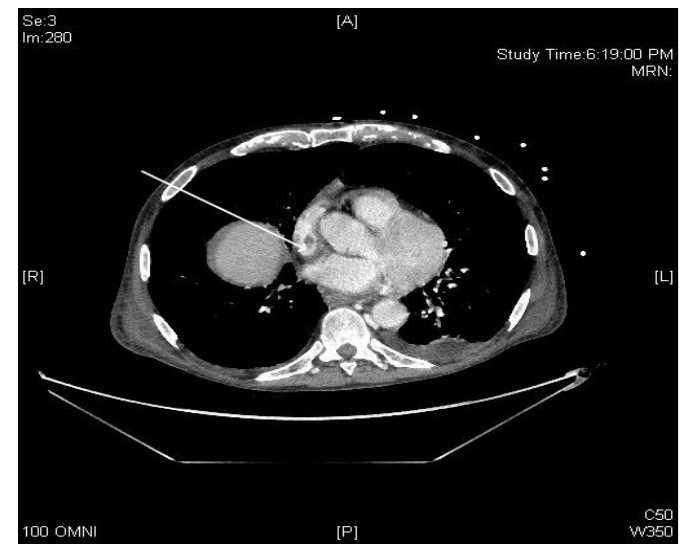
Figure 6. Computed tomography image demonstrating filling defect in SVC distal to central venous port tip (arrow). SVC , superior vena